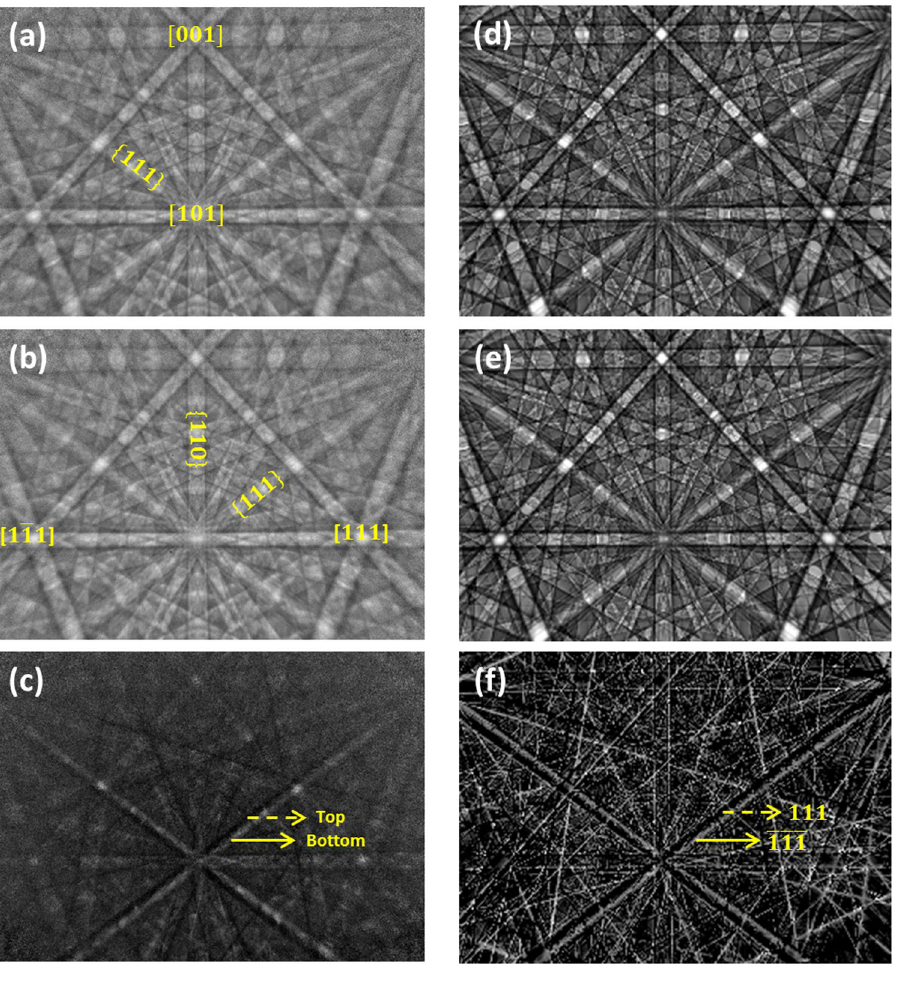
Figure 3. Comparison of experimental and simulated EBSD patterns. ( a ) Experimental EBSD pattern from the red dotted area, see Fig. 1c (for e.g.; the location of cation (Ga) atoms), with r = 0.627 and ϕ 2 = 180.9 ° and (b) from the purple dotted area (for e.g.: P site with r = 0.627 and ϕ 2 = 270.9 °) and (d and e) the corresponding dynamical simulations. ( c) Normalised difference intensity image (I a − I b )/(I a + I b ) of the two experimental patterns and ( f ) normalised difference intensity image of the two simulated patterns. The strong asymmetric intensity difference between the {111} and {111} in the normalised difference intensity images clearly indicates the crystal structure rotation by 90° confirming the presence of APDs in the GaP thin